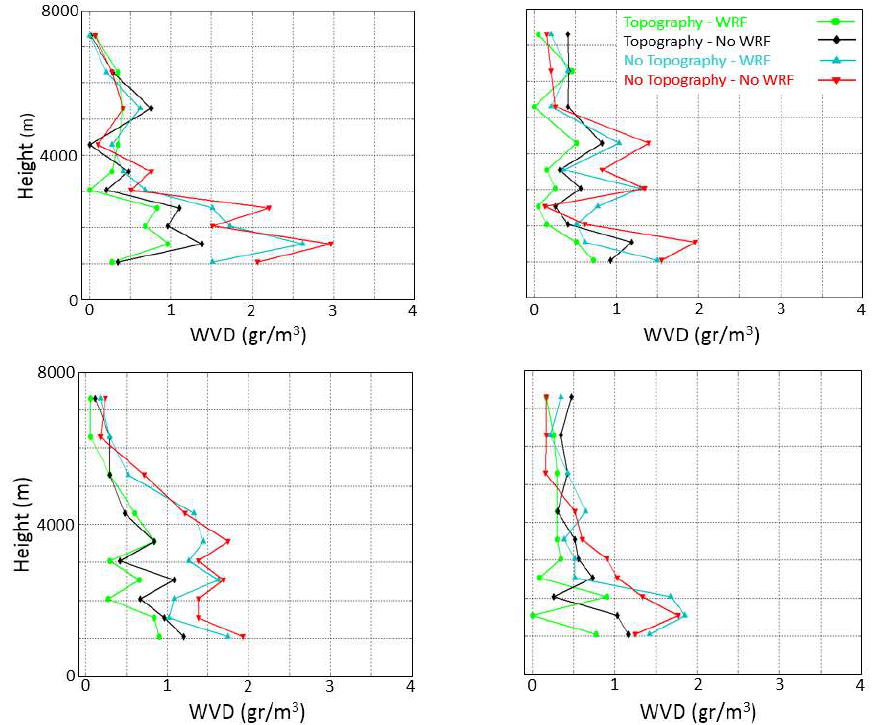
Figure 11. Two examples of comparison between the obtained WVD and radiosonde observations.